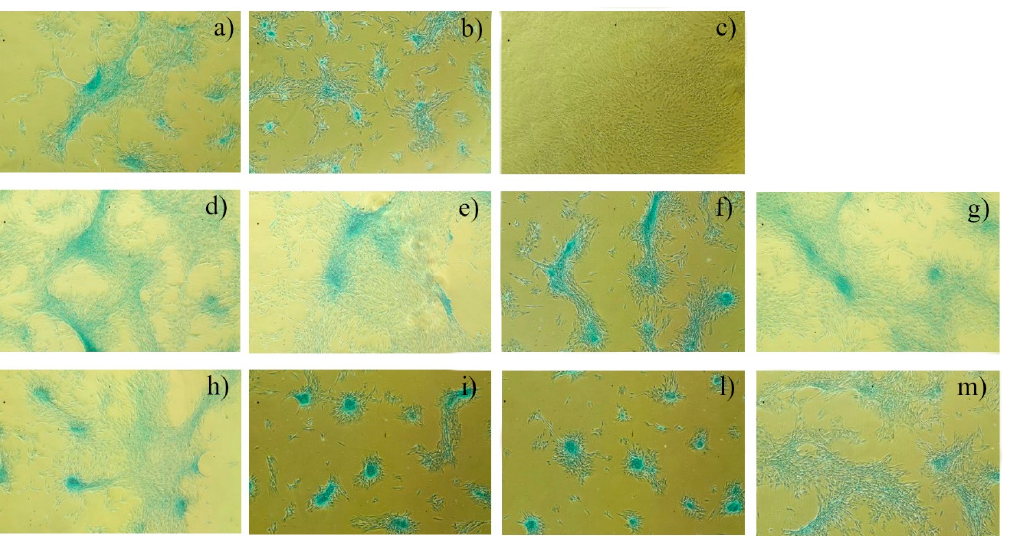
Figure 4. Capability of BMMSCs to differentiate, after three weeks of incubation, into chondrogenic